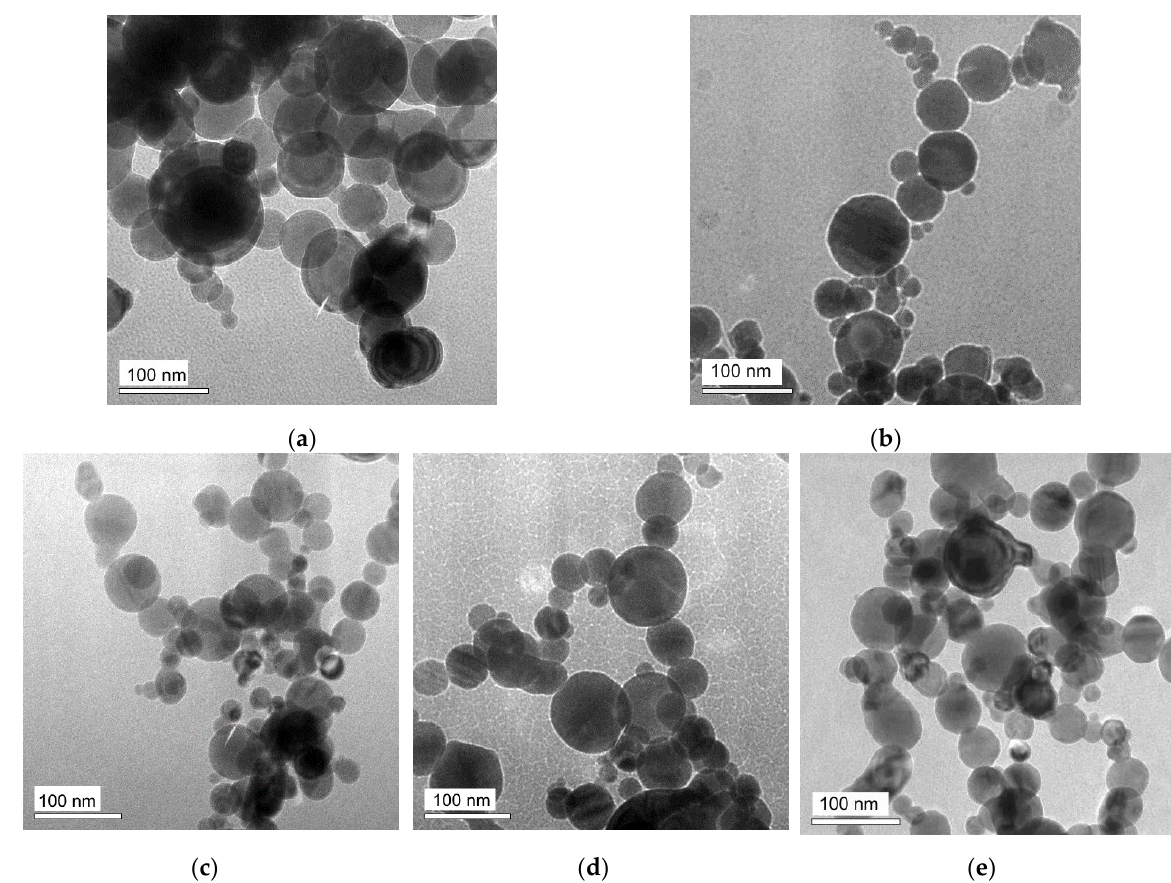
Figure 1. TEM images of zero-valent metal EEW MNPs of different types. ( a )—Fe, ( b )—Ni50Fe50, ( c )—Ni64Fe36, ( d )— Ni82Fe18, ( e )—Ni.